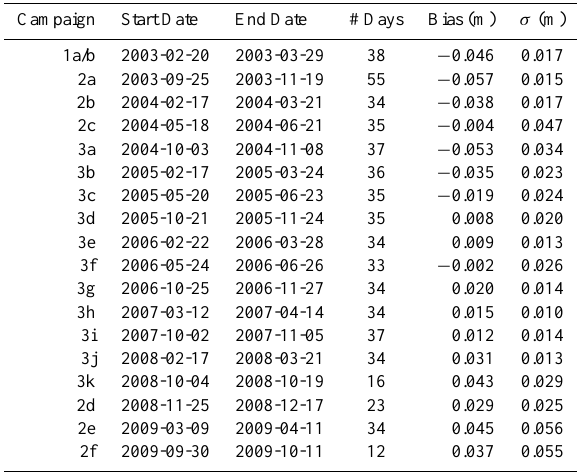
Table 1. Estimated ICESat campaign biases and uncertainties by